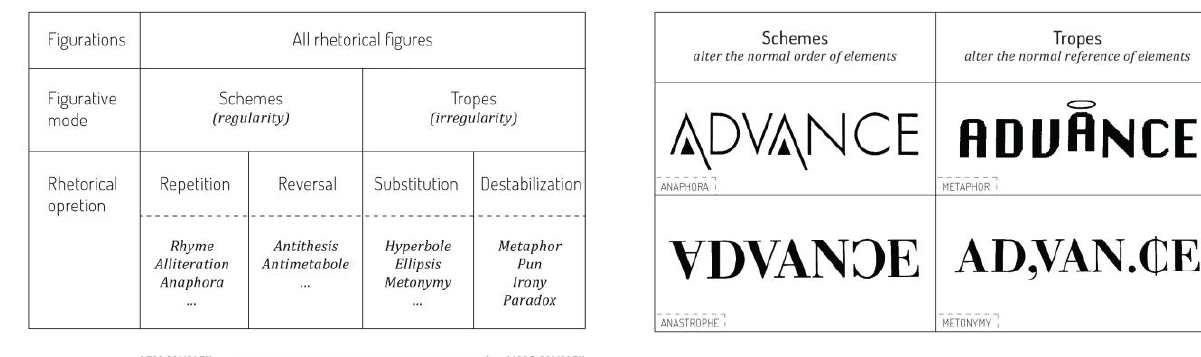
Figure 1. A taxonomy of rhetorical figures devised by McQuarrie and Mick (1996). The grid shows three–step cate- gorization where division of rhetorical figures is based on the regularity or irregularity of the form.